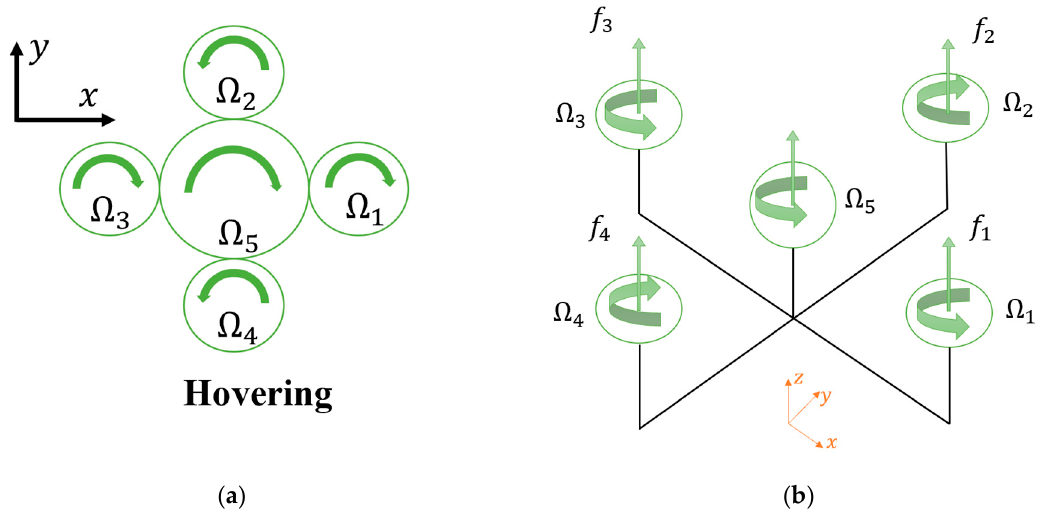
Figure 2. ( a ) Scheme and ( b ) motion principle of the modified UAV [54].